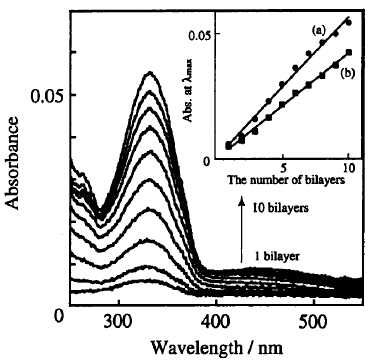
Figure 4. UV–visible absorption spectra of LbL films composed of Polymer 6 and PSS as a function of the number of layers. Inset shows the plots of absorbance of the Polymer 6 /PSS (a) and Polymer 6 /PVS (b) films at 330 nm. Reprinted with permission from Ref. [57]. Copyright 2002 American Chemical Society.